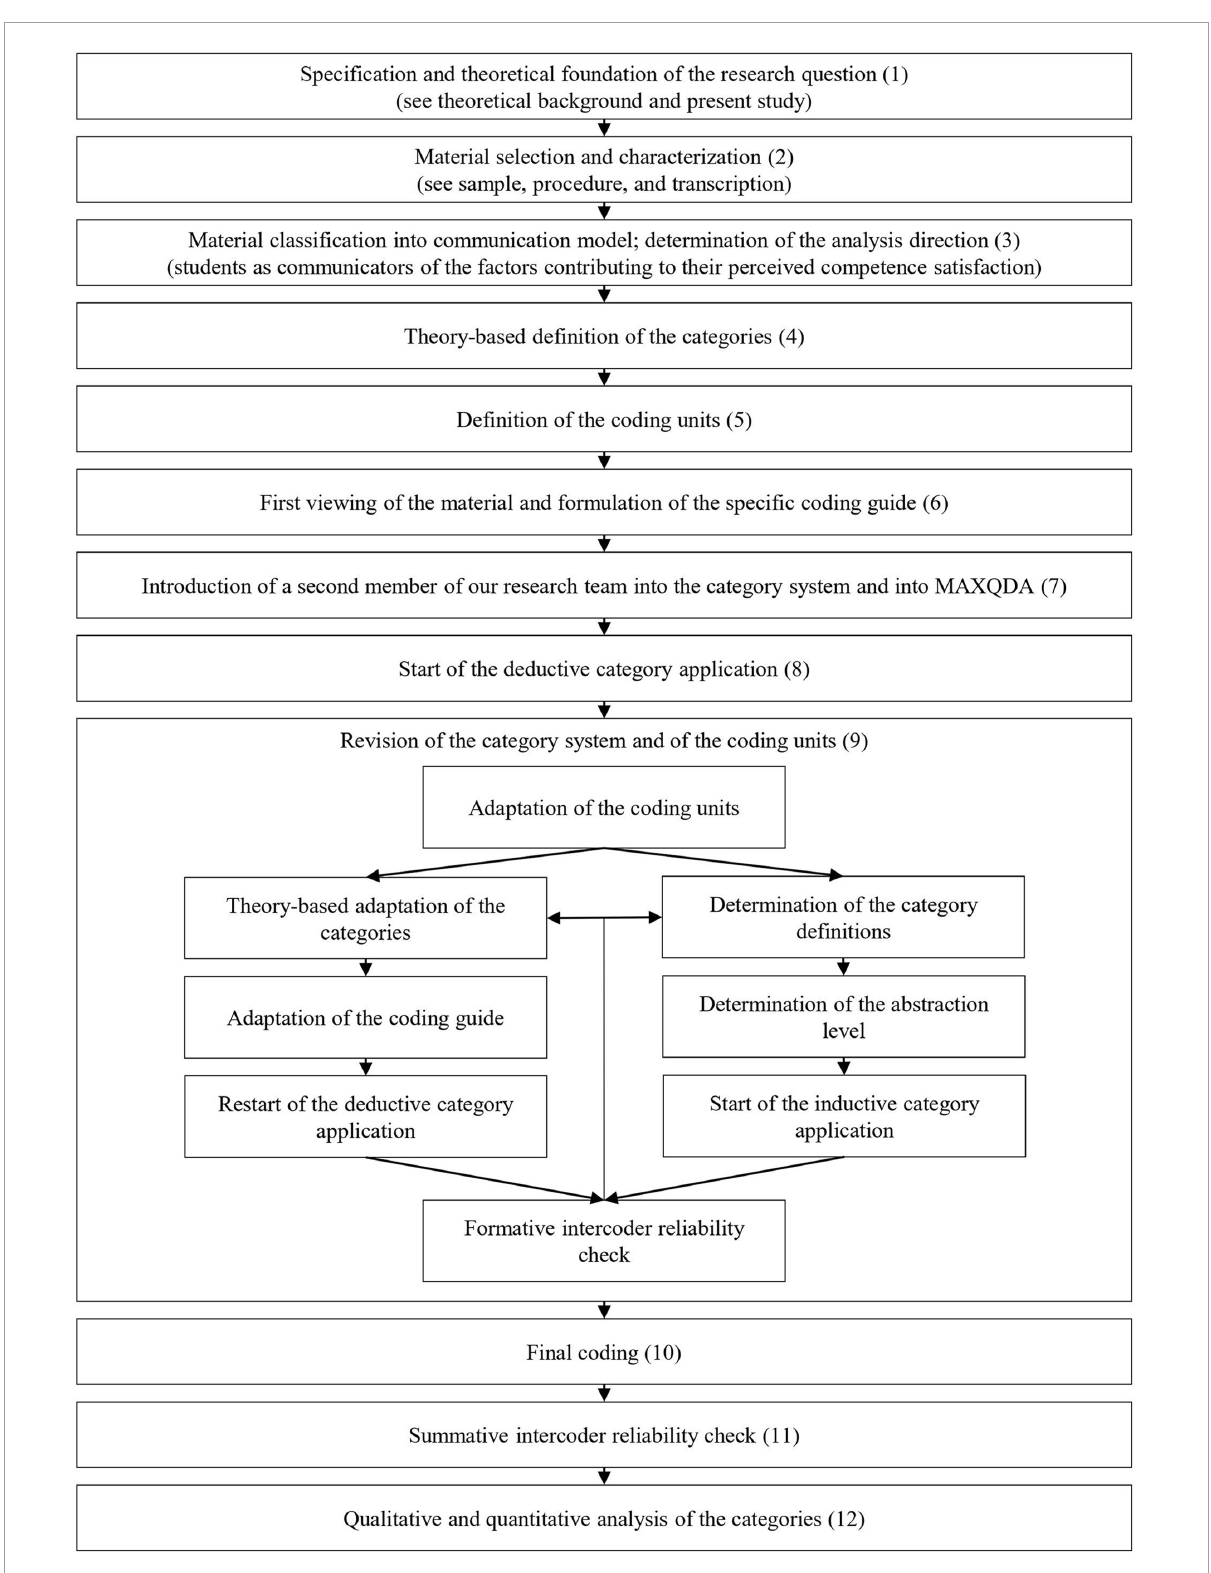
FIGURE1 Procedural model of the qualitative content analysis applied in the present study. Adapted from Mayring and Brunner (2006).